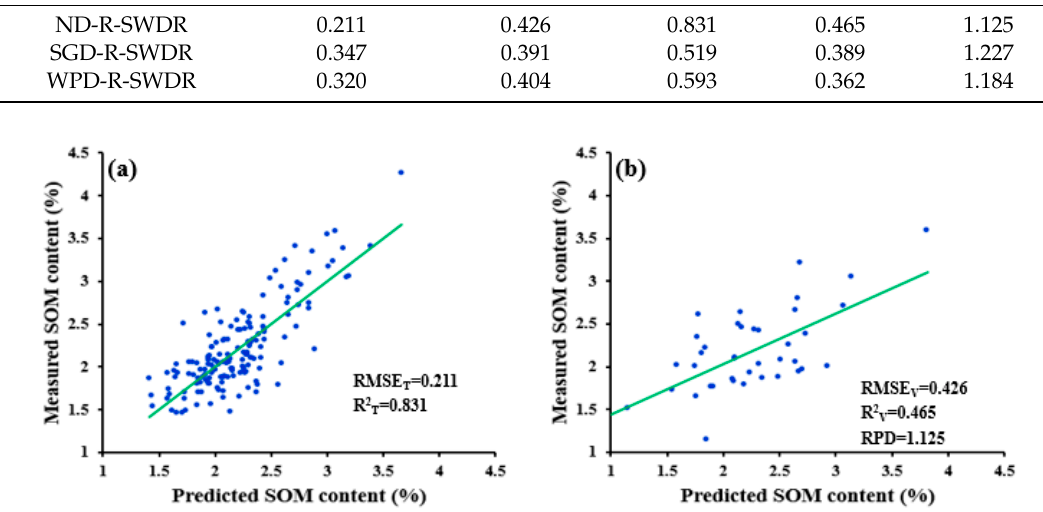
Figure 10. SOM content estimation results based on PLSR for the ( a ) training and ( b ) validation set for data subjected to the ND-R-SWDR pretreatment.